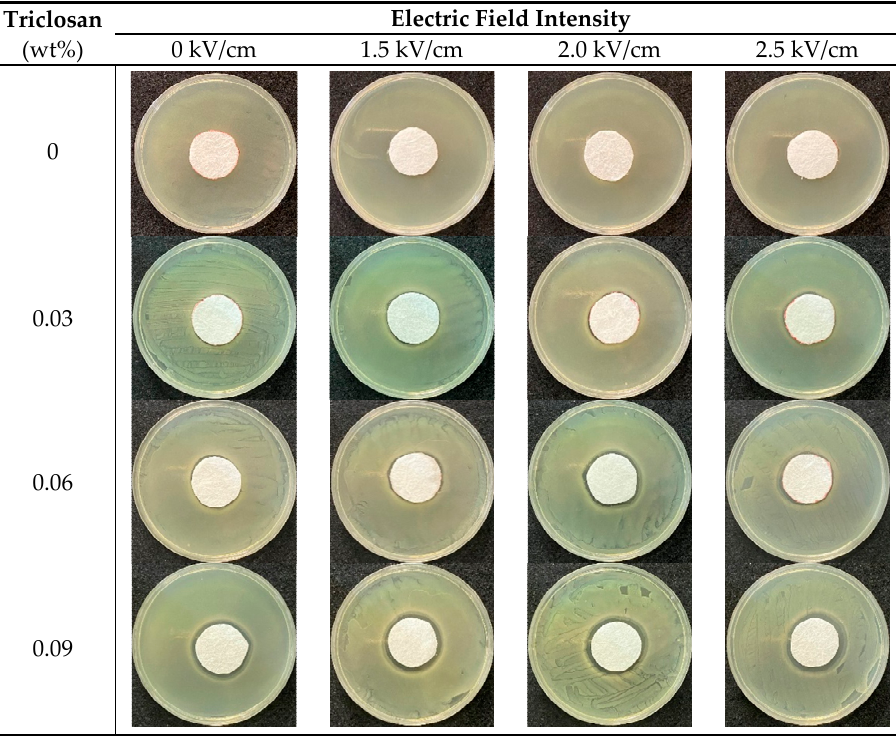
Figure 3. Inhibition zone against E. coli of samples as related to triclosan amount (rows 1-4: 0, 0.03, 0.06, and 0.09 wt%) and electric field intensity (columns 1–3: 1.5, 2.0, and 2.5 kV/cm).